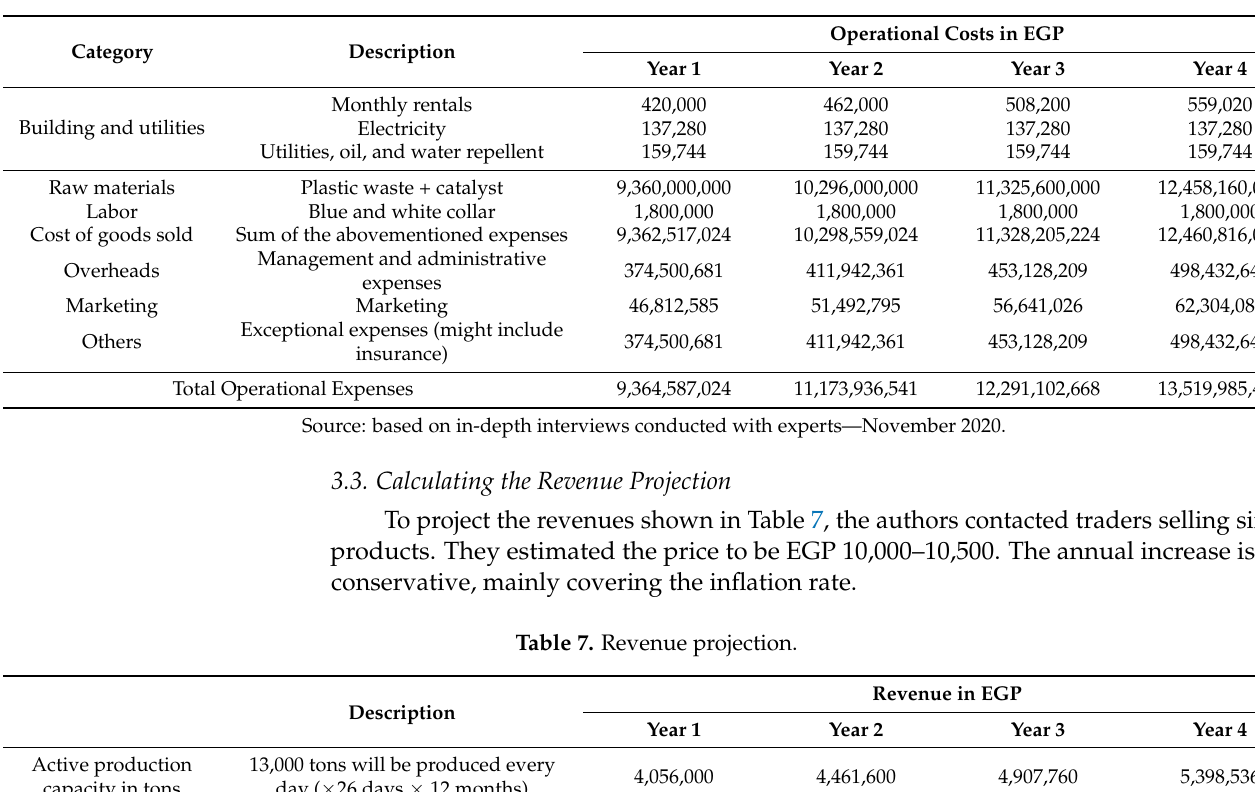
Table 6. Operational costs.